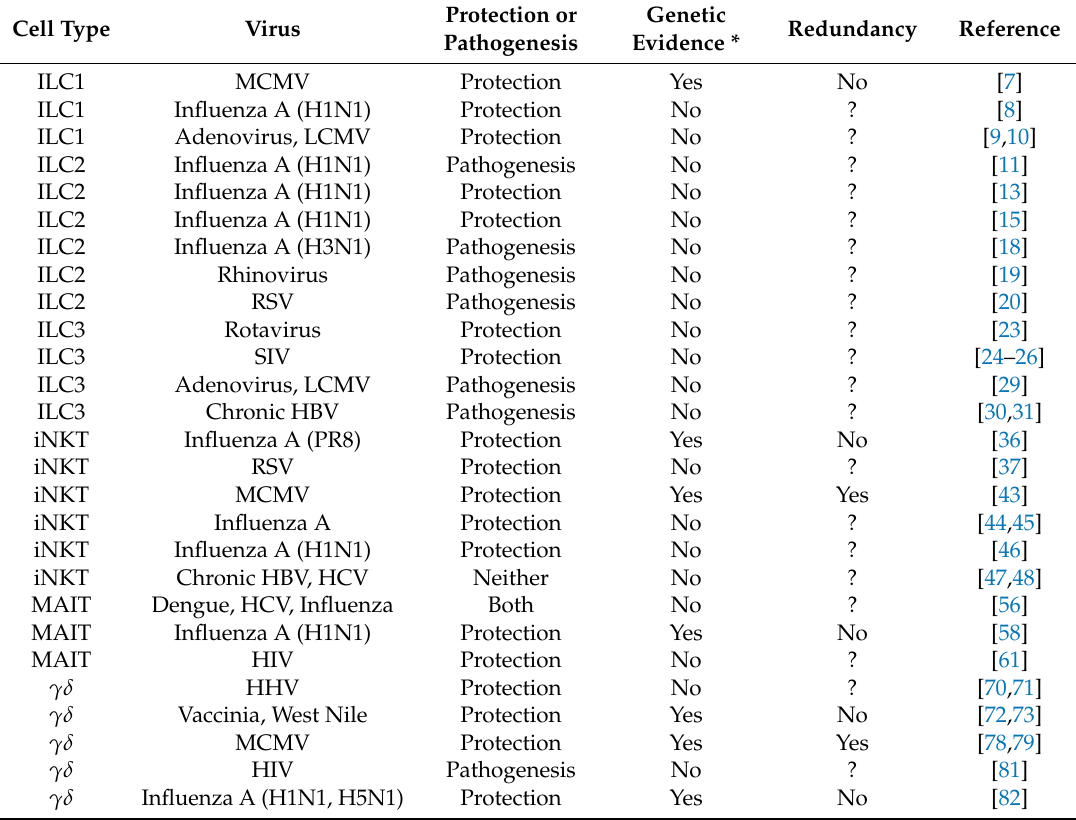
Table 1. Protective and pathologic tissue-resident lymphocyte responses to viral